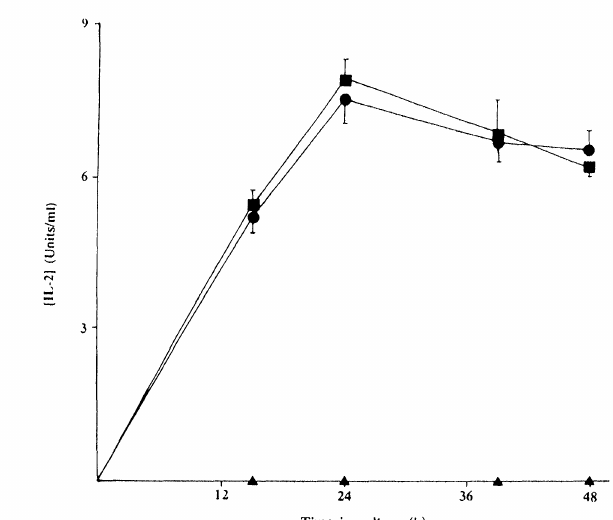
FIG. 1. The concentration of IL-2 in the culture medium of rat lymphocytes. Rat lymph node lymphocytes were cultured for in the absence (A) or presence (,, O) of Con A. In some cases the medium was also supplemented with 100/M bovine serum albumin (O). At various times the medium was removed, serially diluted two-fold and the concentration of IL-2 determined using the CTLL-2 cell line (see Materials and Methods). Data are the mean___SEM of twelve determinations.